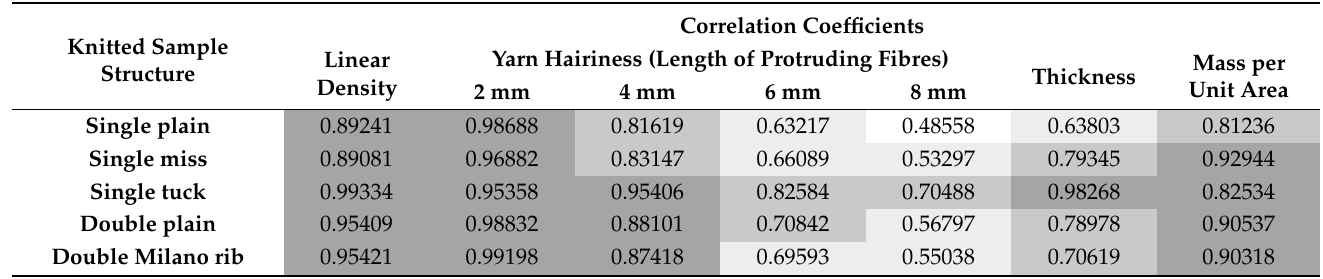
Table 8. The correlation coefficients of heat resistance and selected yarn and fabric